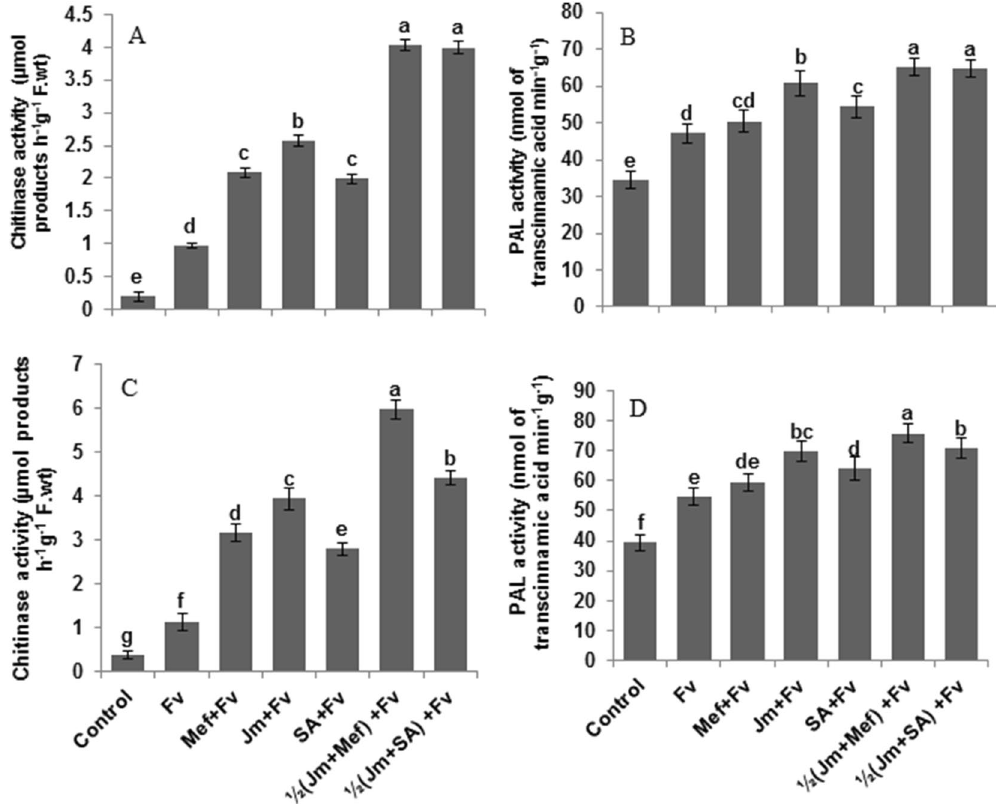
Figure 8. Effect of seed treatments with J. mimosifolia extract and control formulations on chitinase and PAL activities of maize leaves from plants inoculated with F. verticillioides (21 d after inoculation). ( A ) Chitinase activity (pot experiment), ( B ) PAL activity (pot experiment), ( C ) Chitinase activity (field experiment), ( D ) PAL activity (field experiment). Data are expressed as ± standard deviation of mean (SD) of three replicates. All means sharing the same letter are non-significantly different according to the least significant difference ( LSD ) at P < 0.05. See Table 1 for